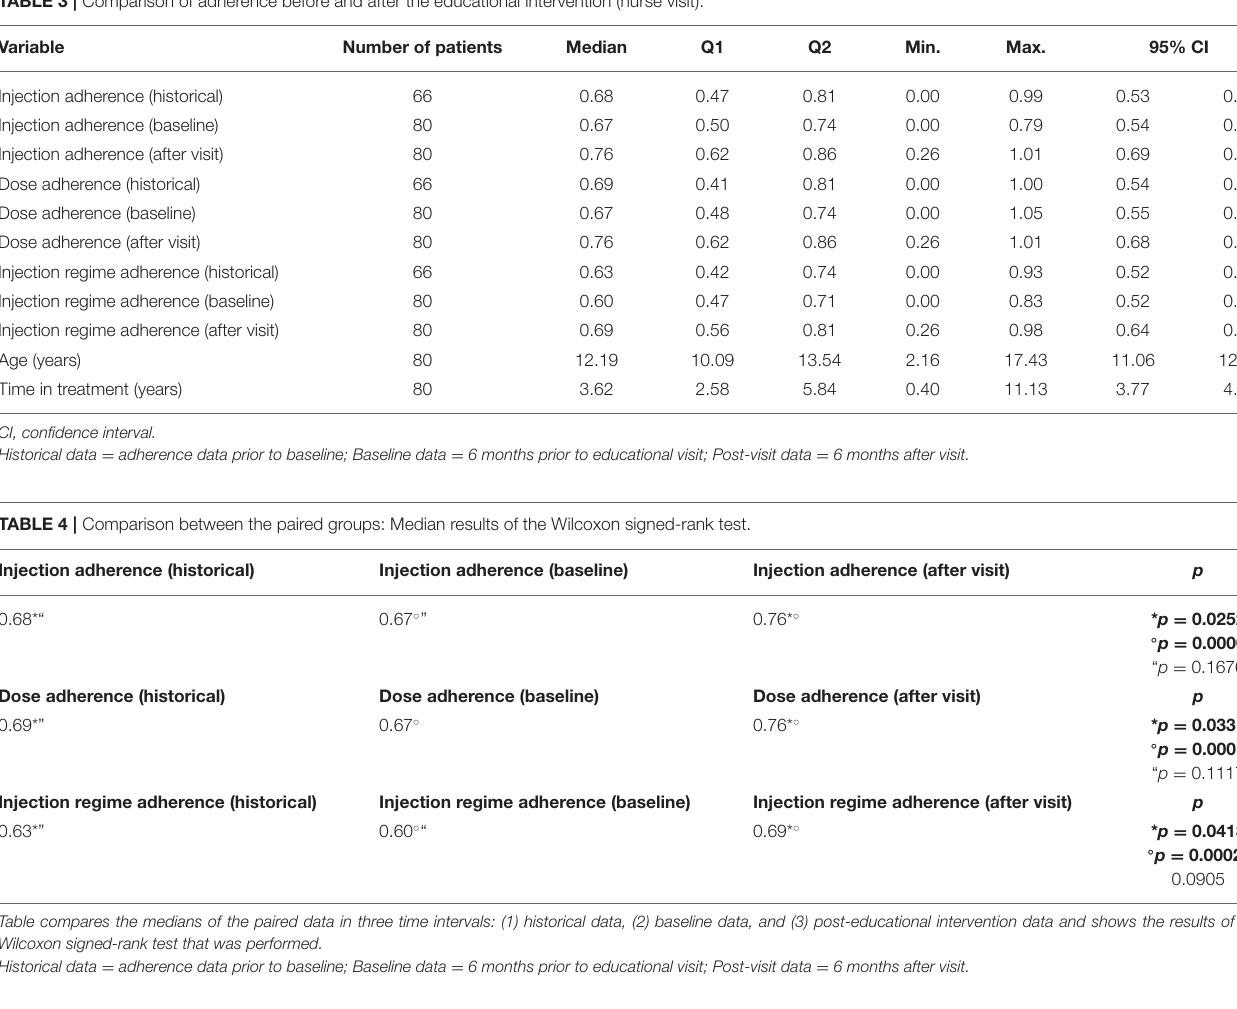
Table compares the medians of the paired data in three time intervals: (1) historical data, (2) baseline data, and (3) post-educational intervention data and shows the results of the Wilcoxon signed-rank test that was